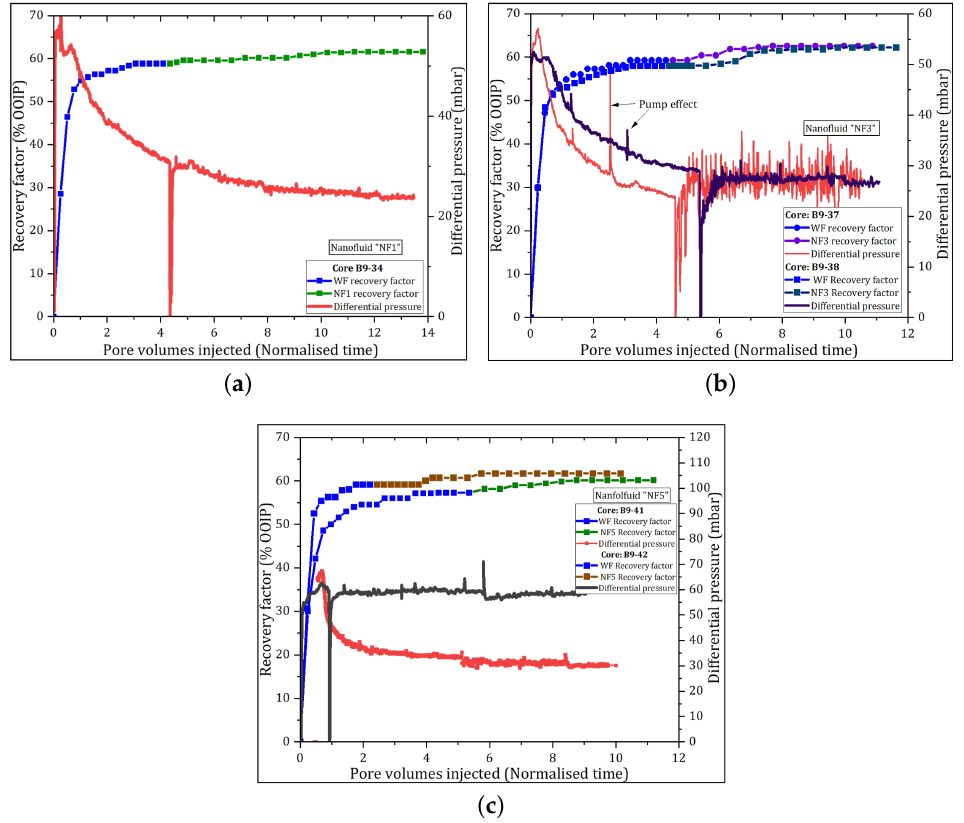
Figure A2. Tertiary oil recoveries and dP versus PV recorded throughout the nanofluid flooding. Two tests were conducted for each nanofluid. ( a ) NF1: the replicate test failed; ( b ) NF3, and ( c )